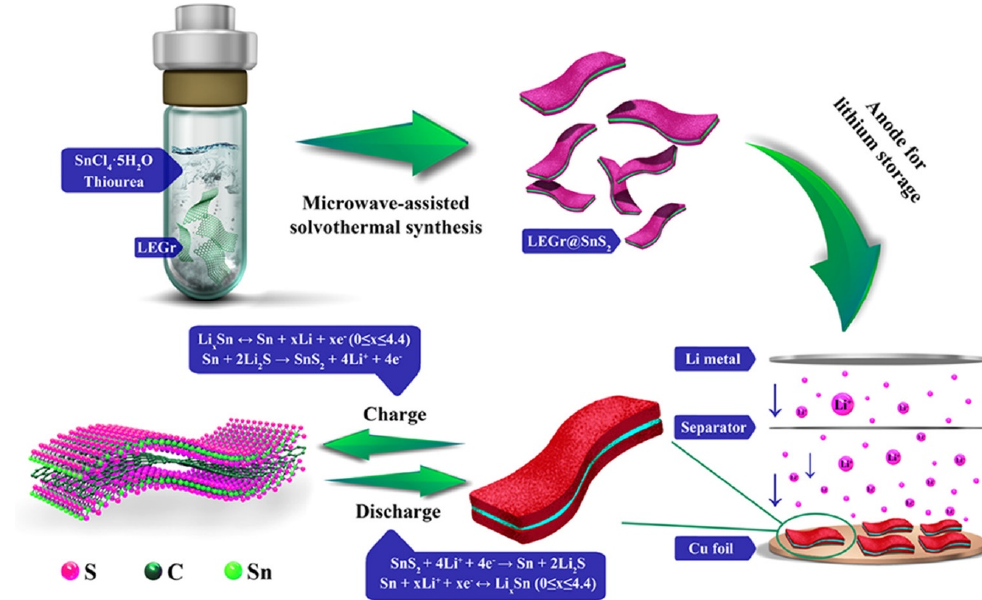
Figure 12. Schematic of the synthesis method and applications of LEGr@SnS 2 heterojunctions. Reproduced with permission from [121].